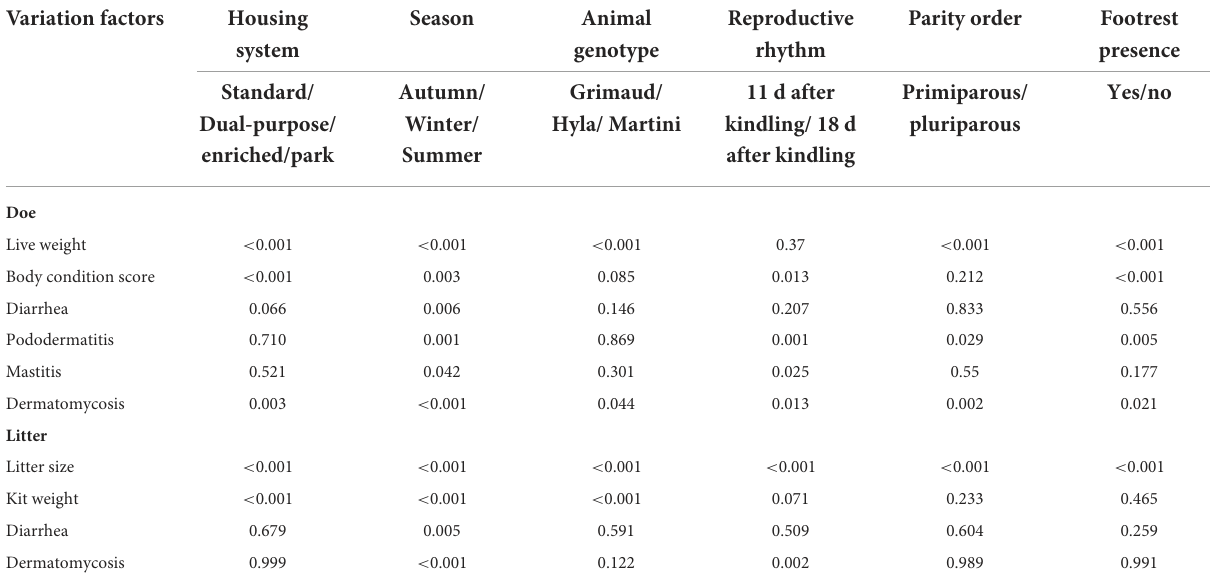
TABLE 5 Risk factors ( P-values ) for animal-based measures in reproducing does and kits at the pre-weaning visit in farms with different housing systems across three